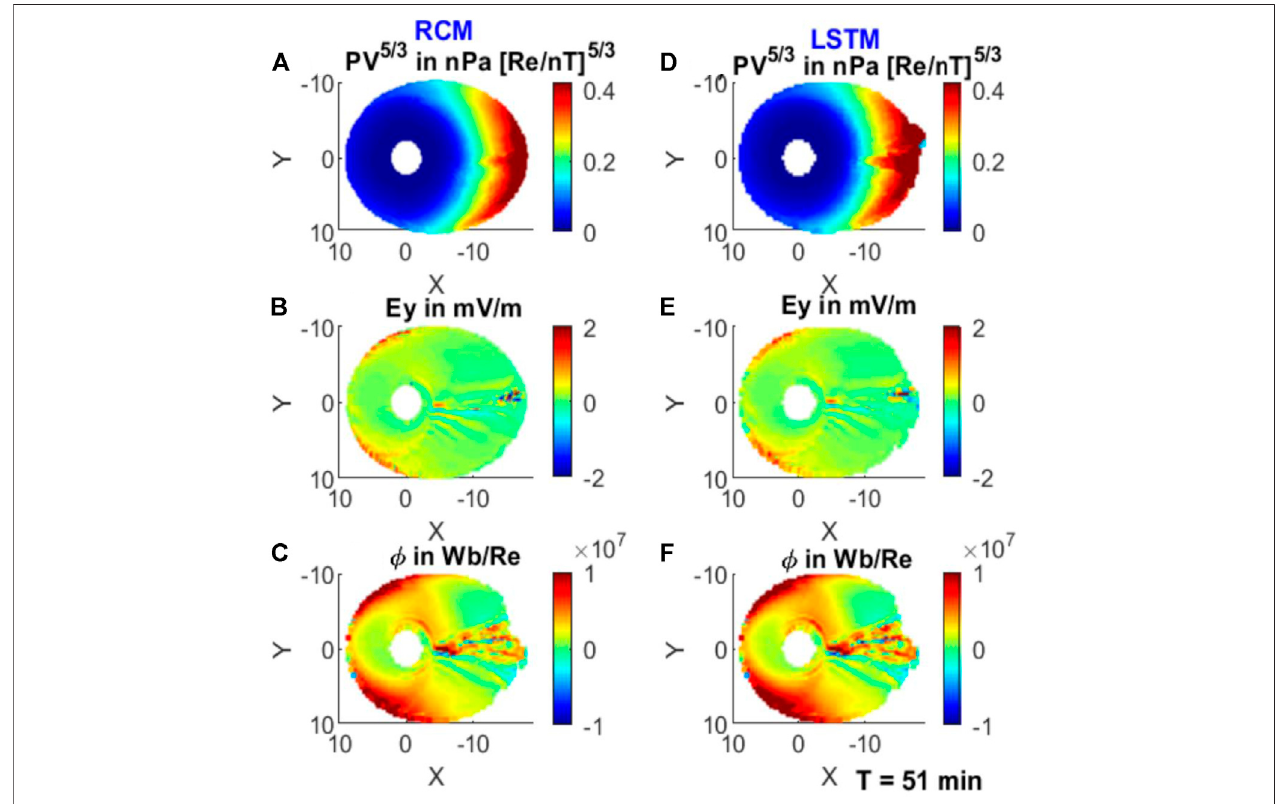
FIGURE 7 | Similar to Figure 5 , but for T (cid:1) 51